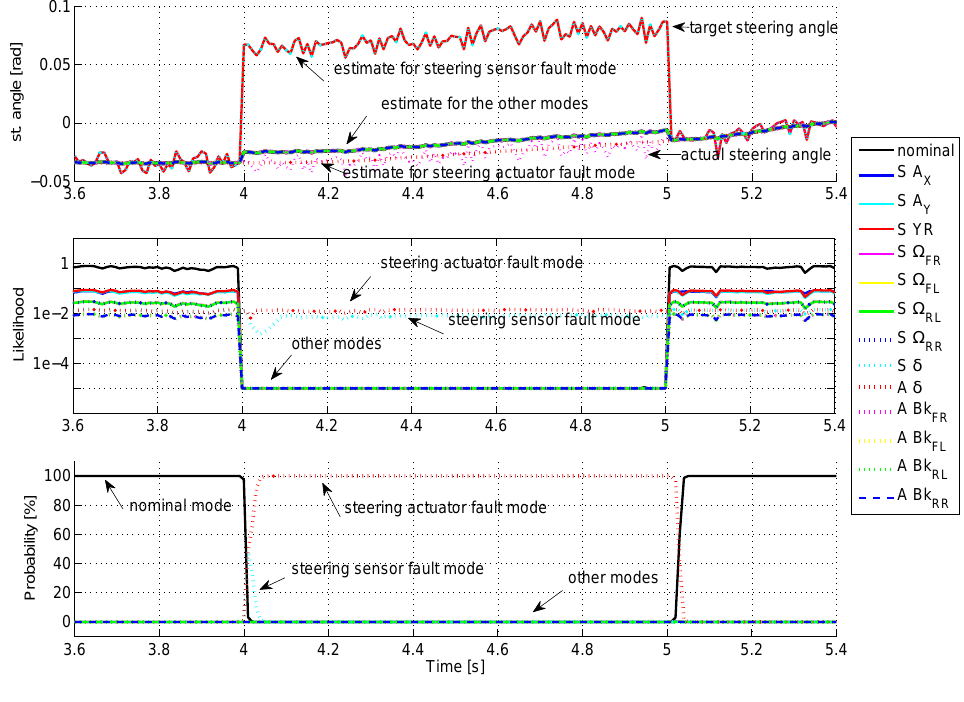
Figure 7. Fault on the steering